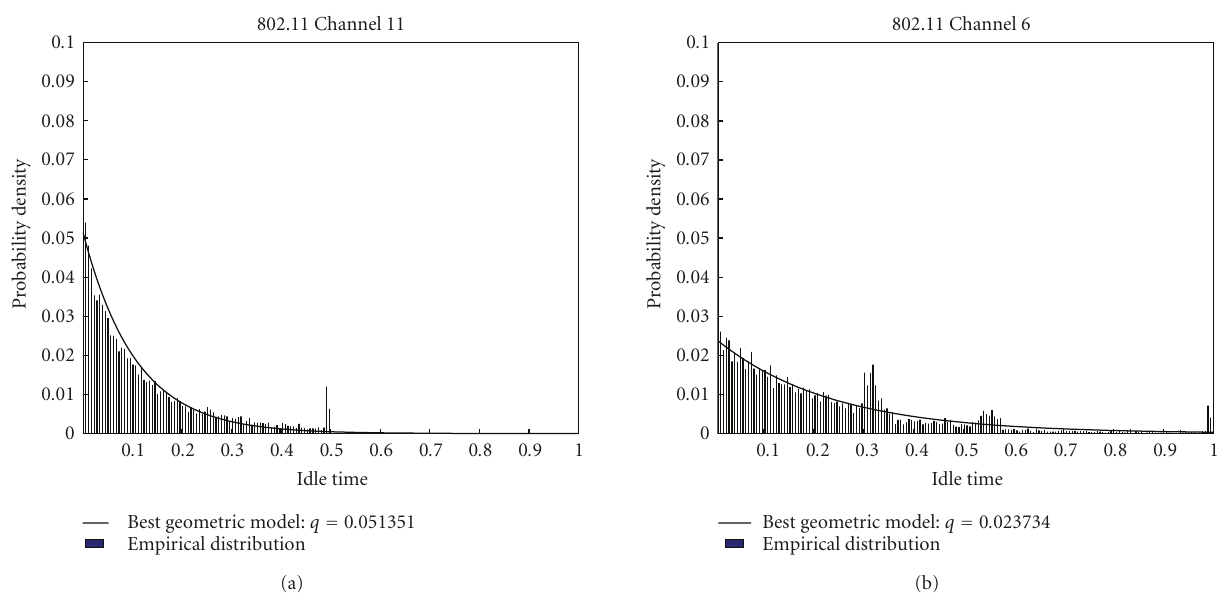
Figure 3: The duration of idle time in between 802.11 packets can be modeled as geometric random